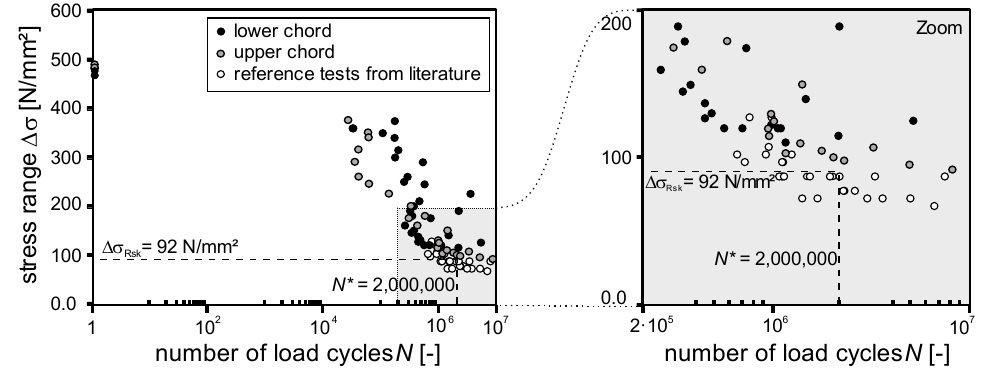
Figure 8. Test results of small size fatigue tests for lower and upper chords with reference tests from literature.